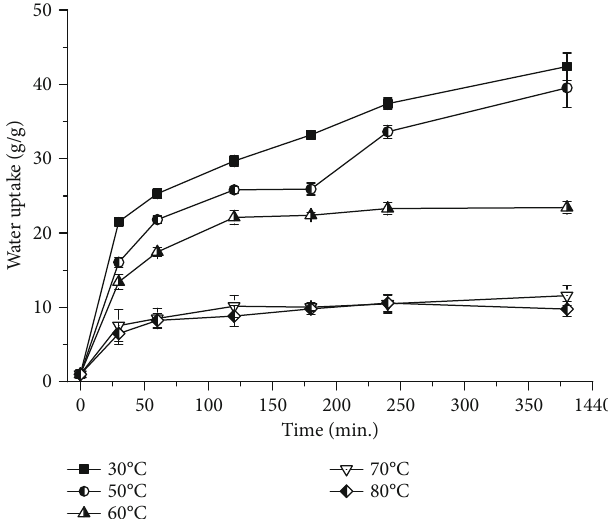
Figure 5: E ff ect of cross-linking temperature on the swelling behaviour of hydrogel H5 over time. The samples were cross-linked for 24h at various temperatures. Water uptake (g/g) was measured by weighing the samples immersed in distilled water, at room temperature for 24 hours.